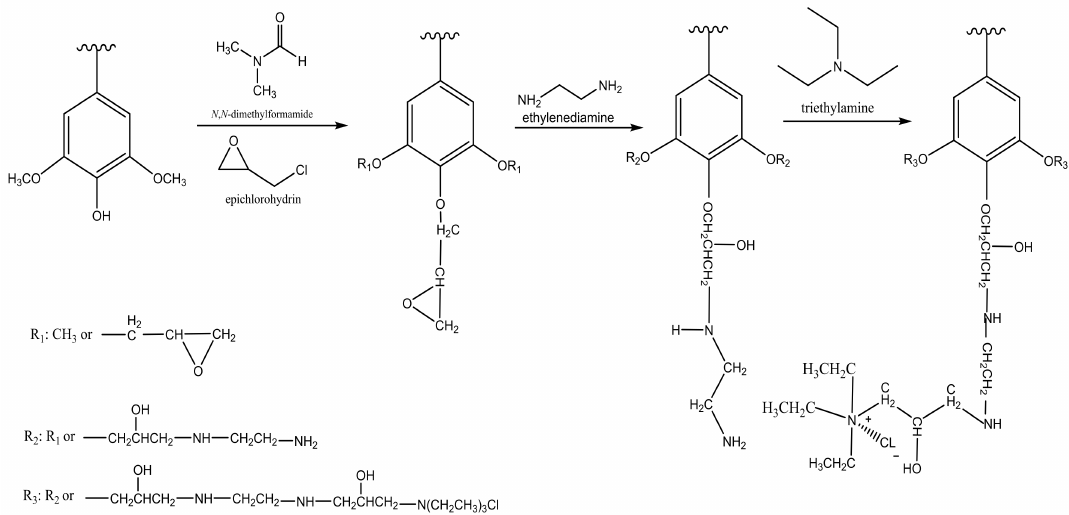
Figure 2. Reaction scheme for producing crosslinked amine-based sludge flocculant [34]. The sludge contained mainly lignin and hence the structure of lignin was selected to represent sludge as the raw material in this reaction. Table 1. Lignin-based flocculants used in different